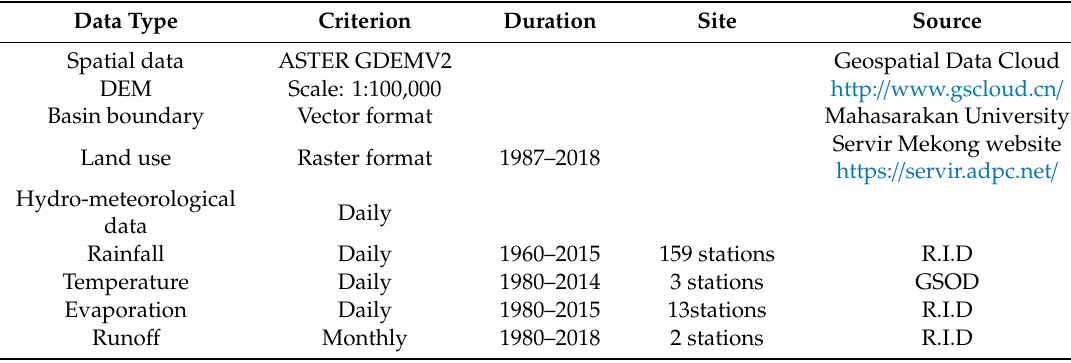
Table 1. Summary list of data collected for this